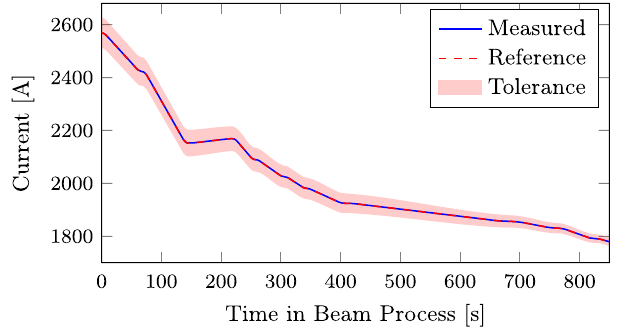
FIG. 3. Principle of the PcInterlock. The reference (red dashed) and measured (blue) PC current is shown over the duration of a beam process. The red shade shows the allowed variation tolerance. Once the blue line exceeds the red band, this circuit is considered as